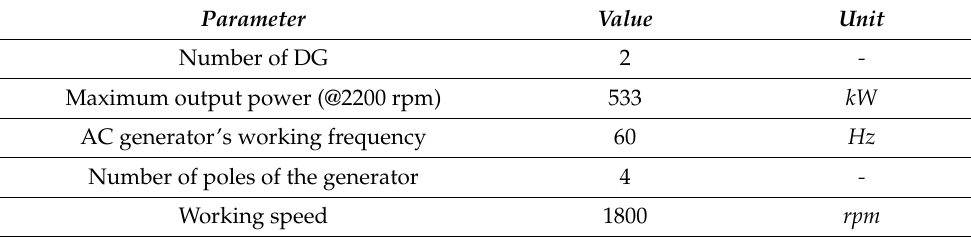
Figure 1. Structure of the employed HEMV system. Table 1. DG’s